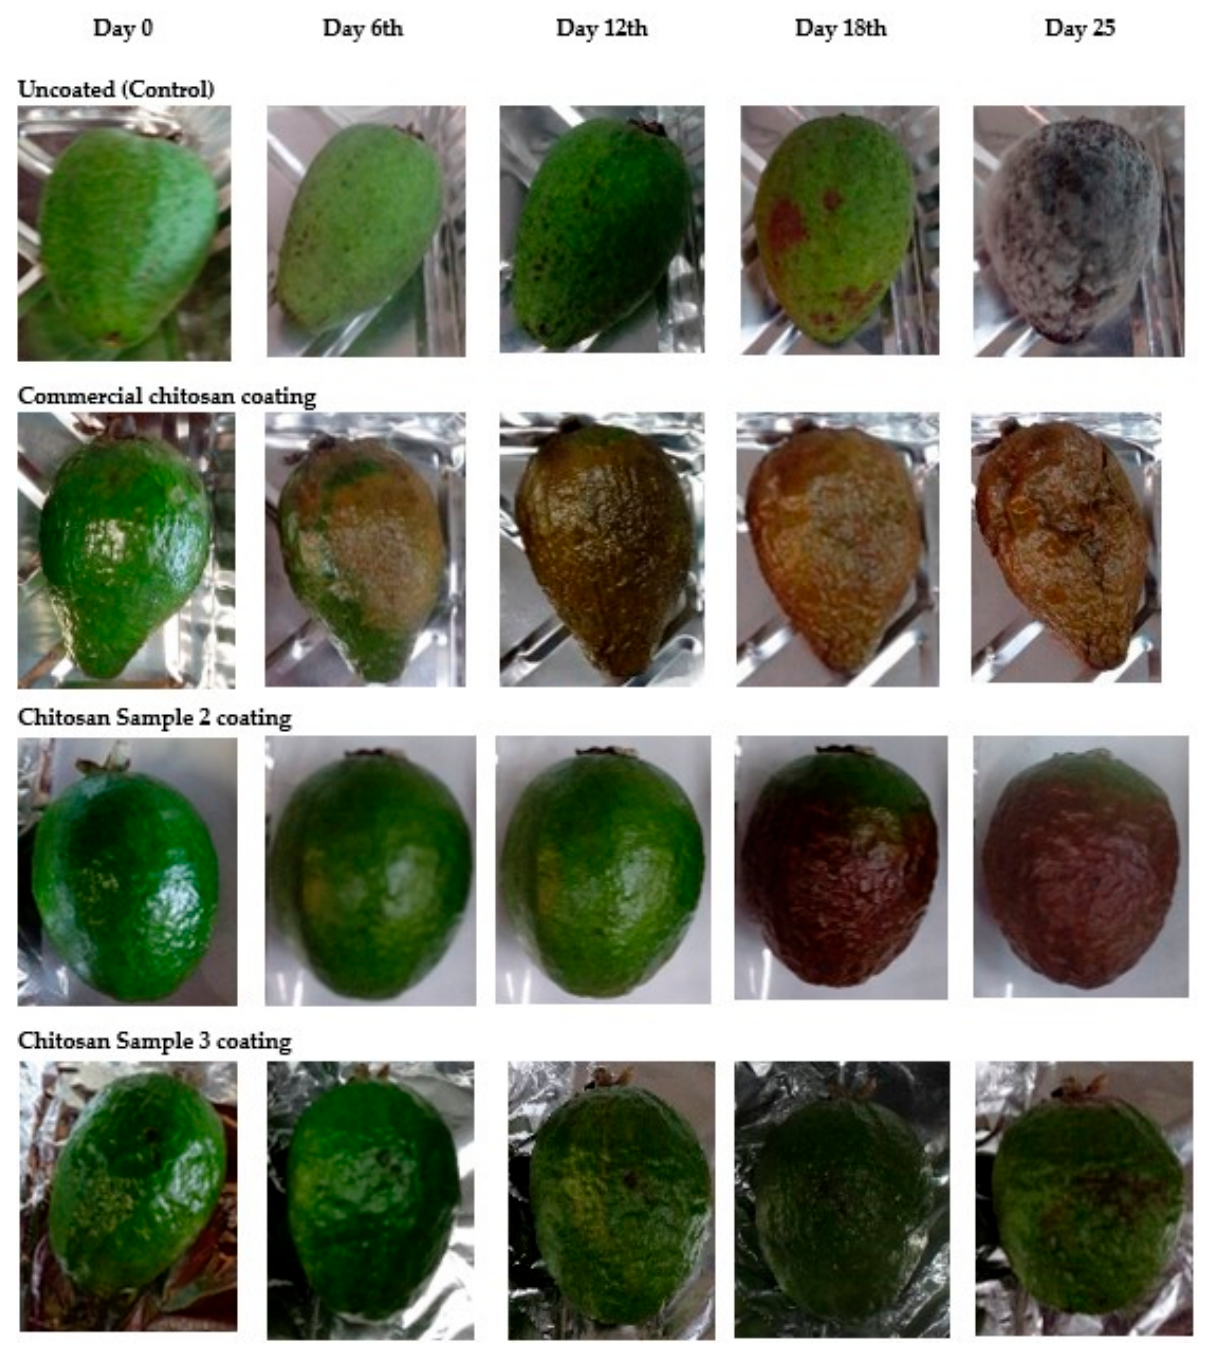
Figure 6. Fruit ripening with and without film coating for different coating samples.